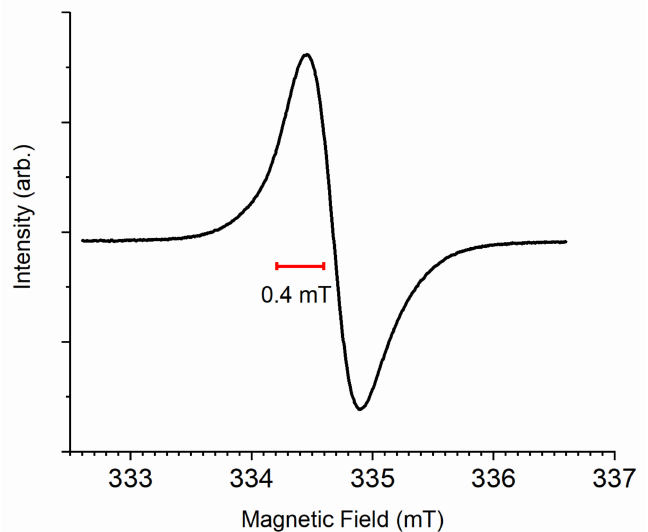
Figure 8. An example electron paramagnetic resonance (EPR) spectrum of melanin. The sample was a solid state, neutral synthetic sample under vacuum. Data used is from Reinecker et al. [89]. Indicated is the width of the spectrum at full width half